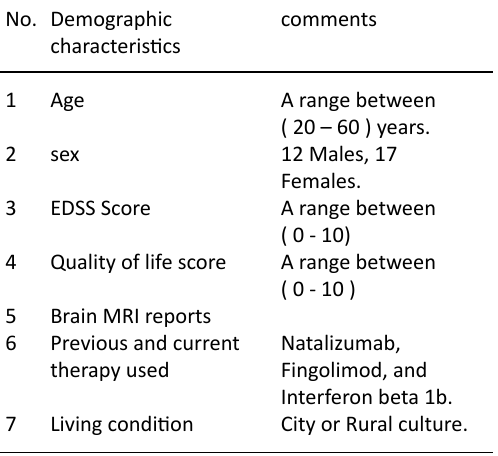
Table 1. Baseline clinical and demographic